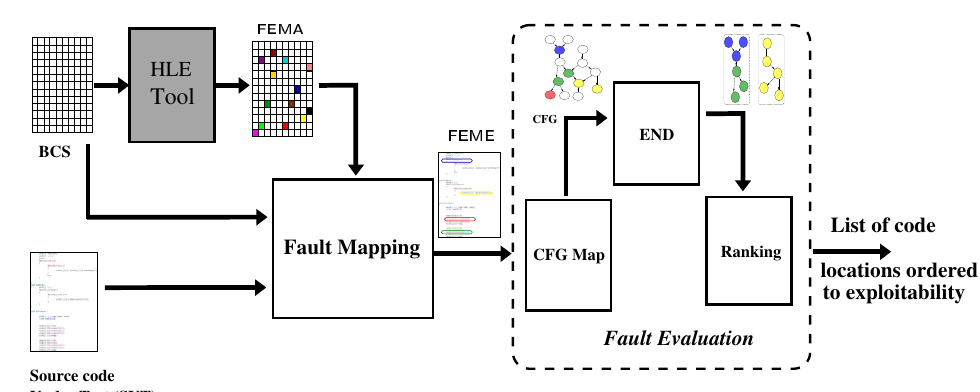
Figure 1: Overview of FEDS Framework to detect exploitability in software implementation. High-Level Evaluation ( HLE ) tools outputs Fault Exploitable Map in Algorithms ( FEMA ) from the high-level representation of the block cipher. Fault Mapping maps FEMA to FEME (Fault Exploitable Map in Implementation). Fault Evaluation works on the Intermediate Representation of the block cipher implementation and determines all fault exploitable instructions in the